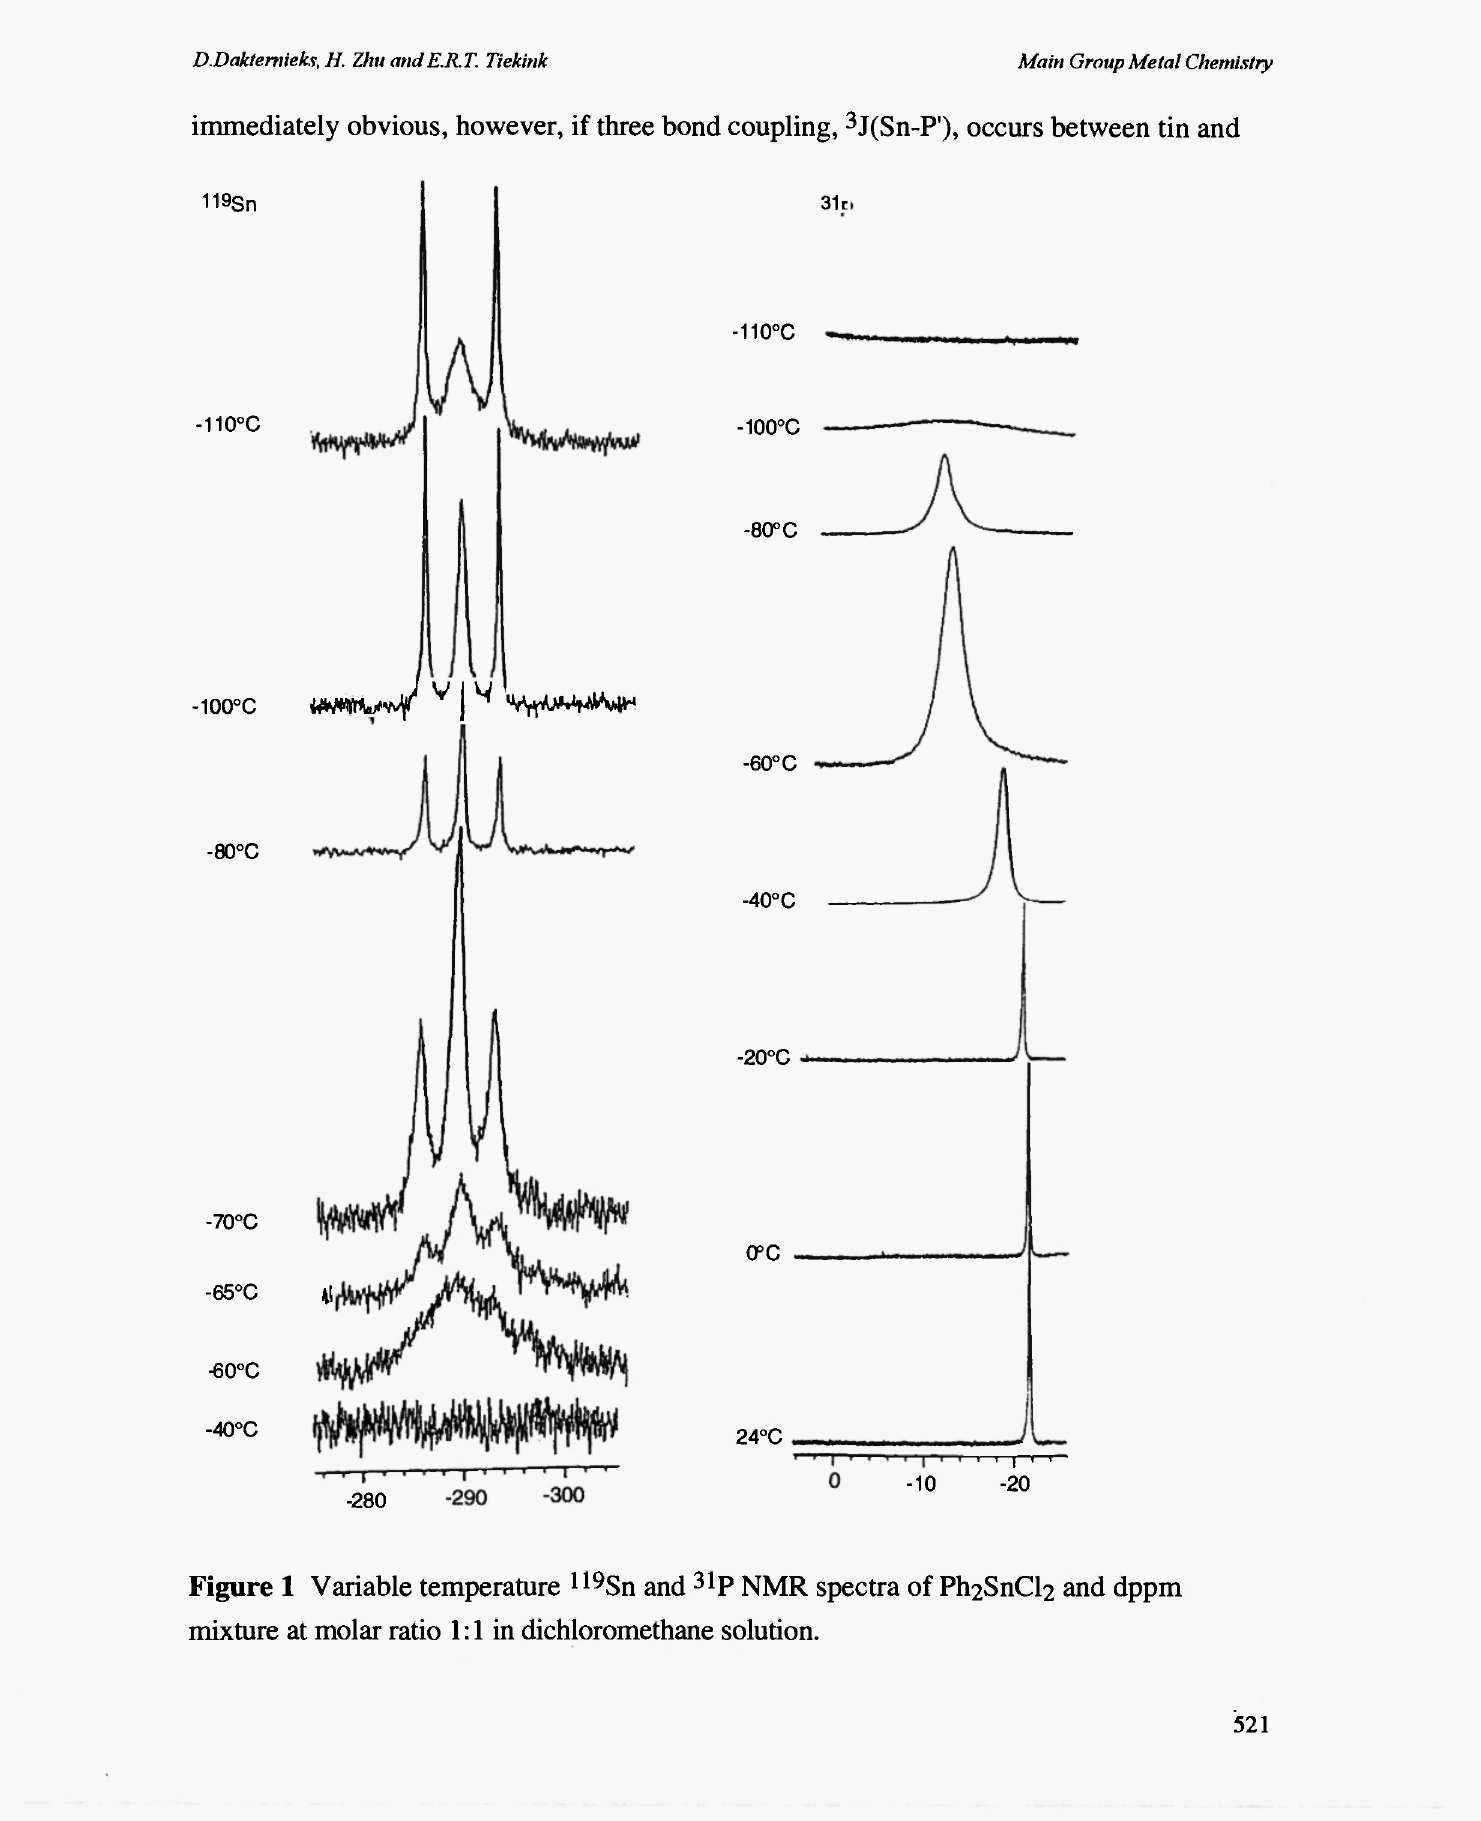
Figure 1 Variable temperature 119 Sn and 31 P NMR spectra of Pti2SnCl2 and dppm mixture at molar ratio 1:1 in dichloromethane